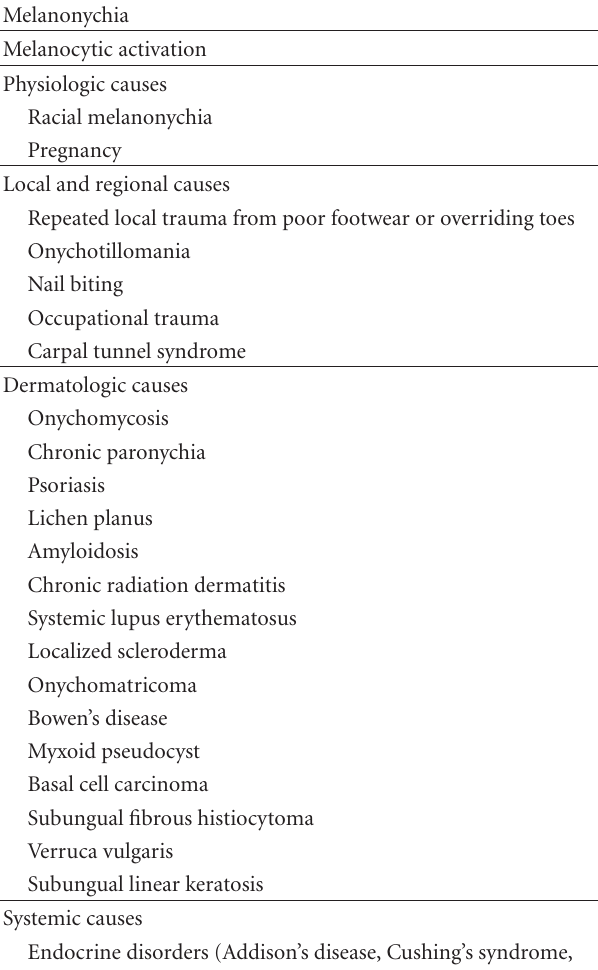
Table 1: Classification of conditions associated with longitudinal melanonychia. Table adapted from J. Andre, N. Lateur. Pigmented nail disorders [2].